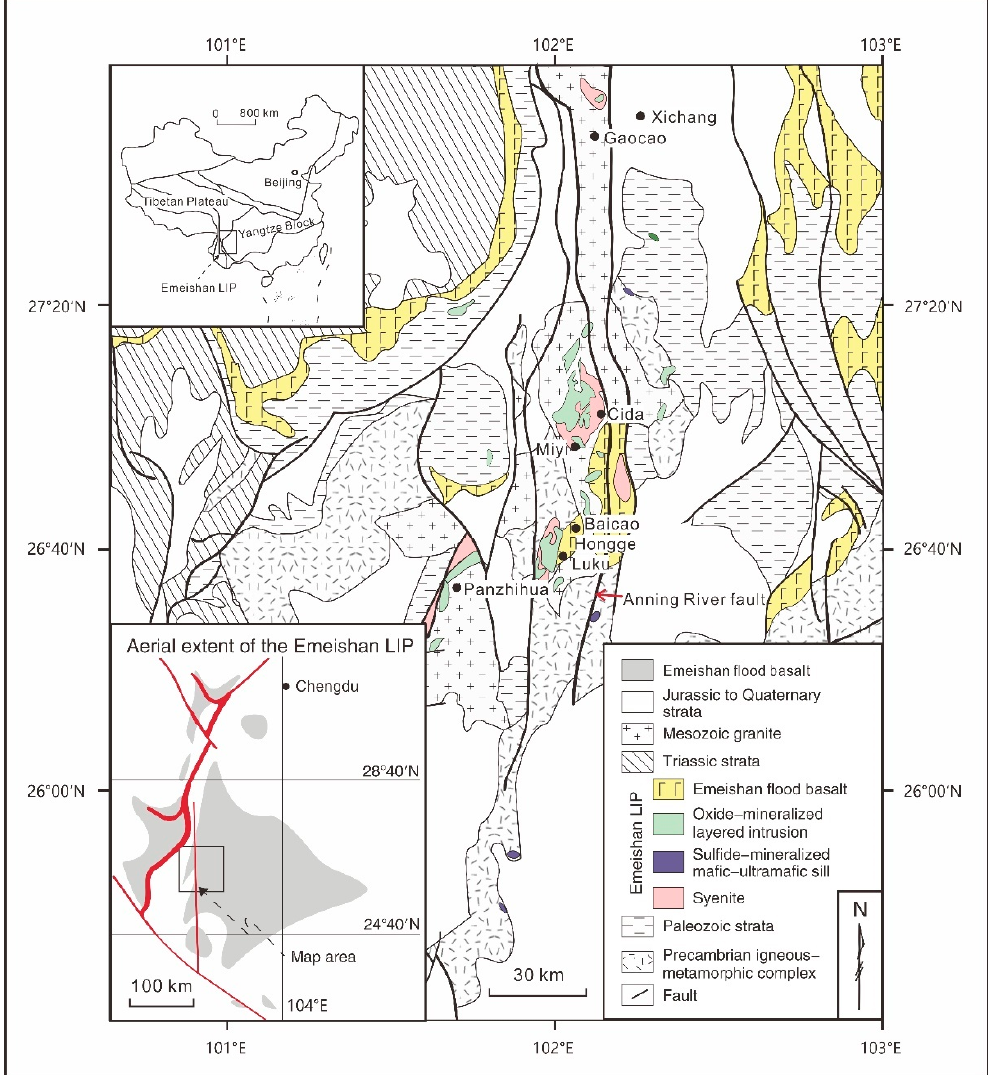
Figure 2. Geologic map of the Panxi region. Modified after [38–40].